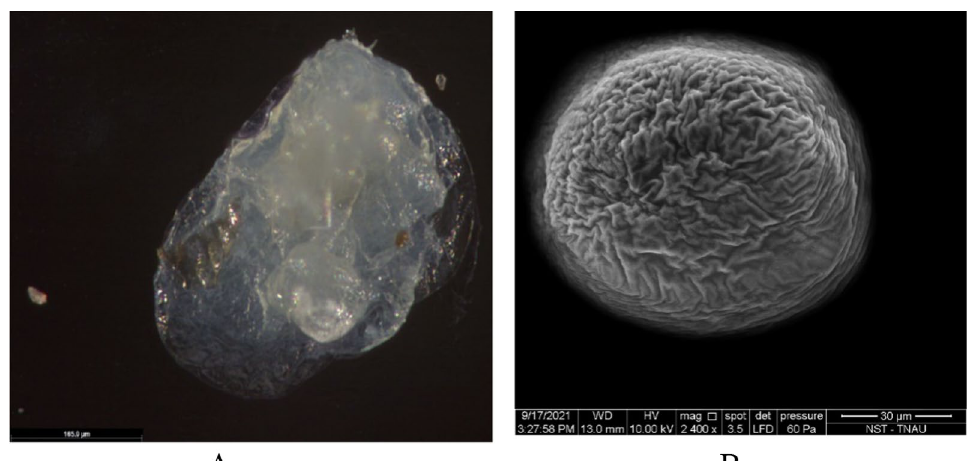
Fig. 6 A, B Pre-pupal stage of T.